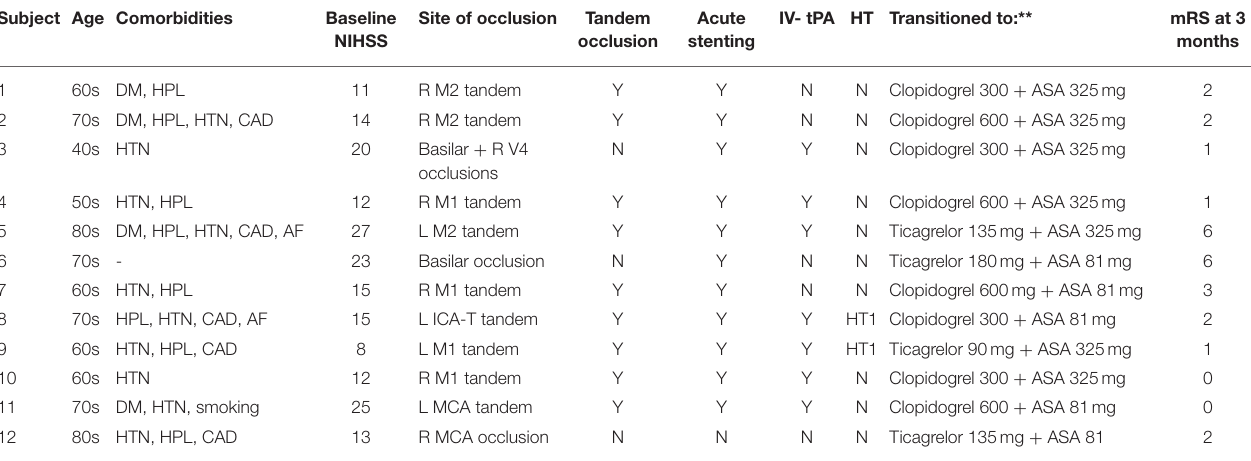
TABLE 2 | Baseline characteristics and treatment variables of patients receiving intravenous cangrelor for acute ischemic stroke. Subject Age Comorbidities Baseline